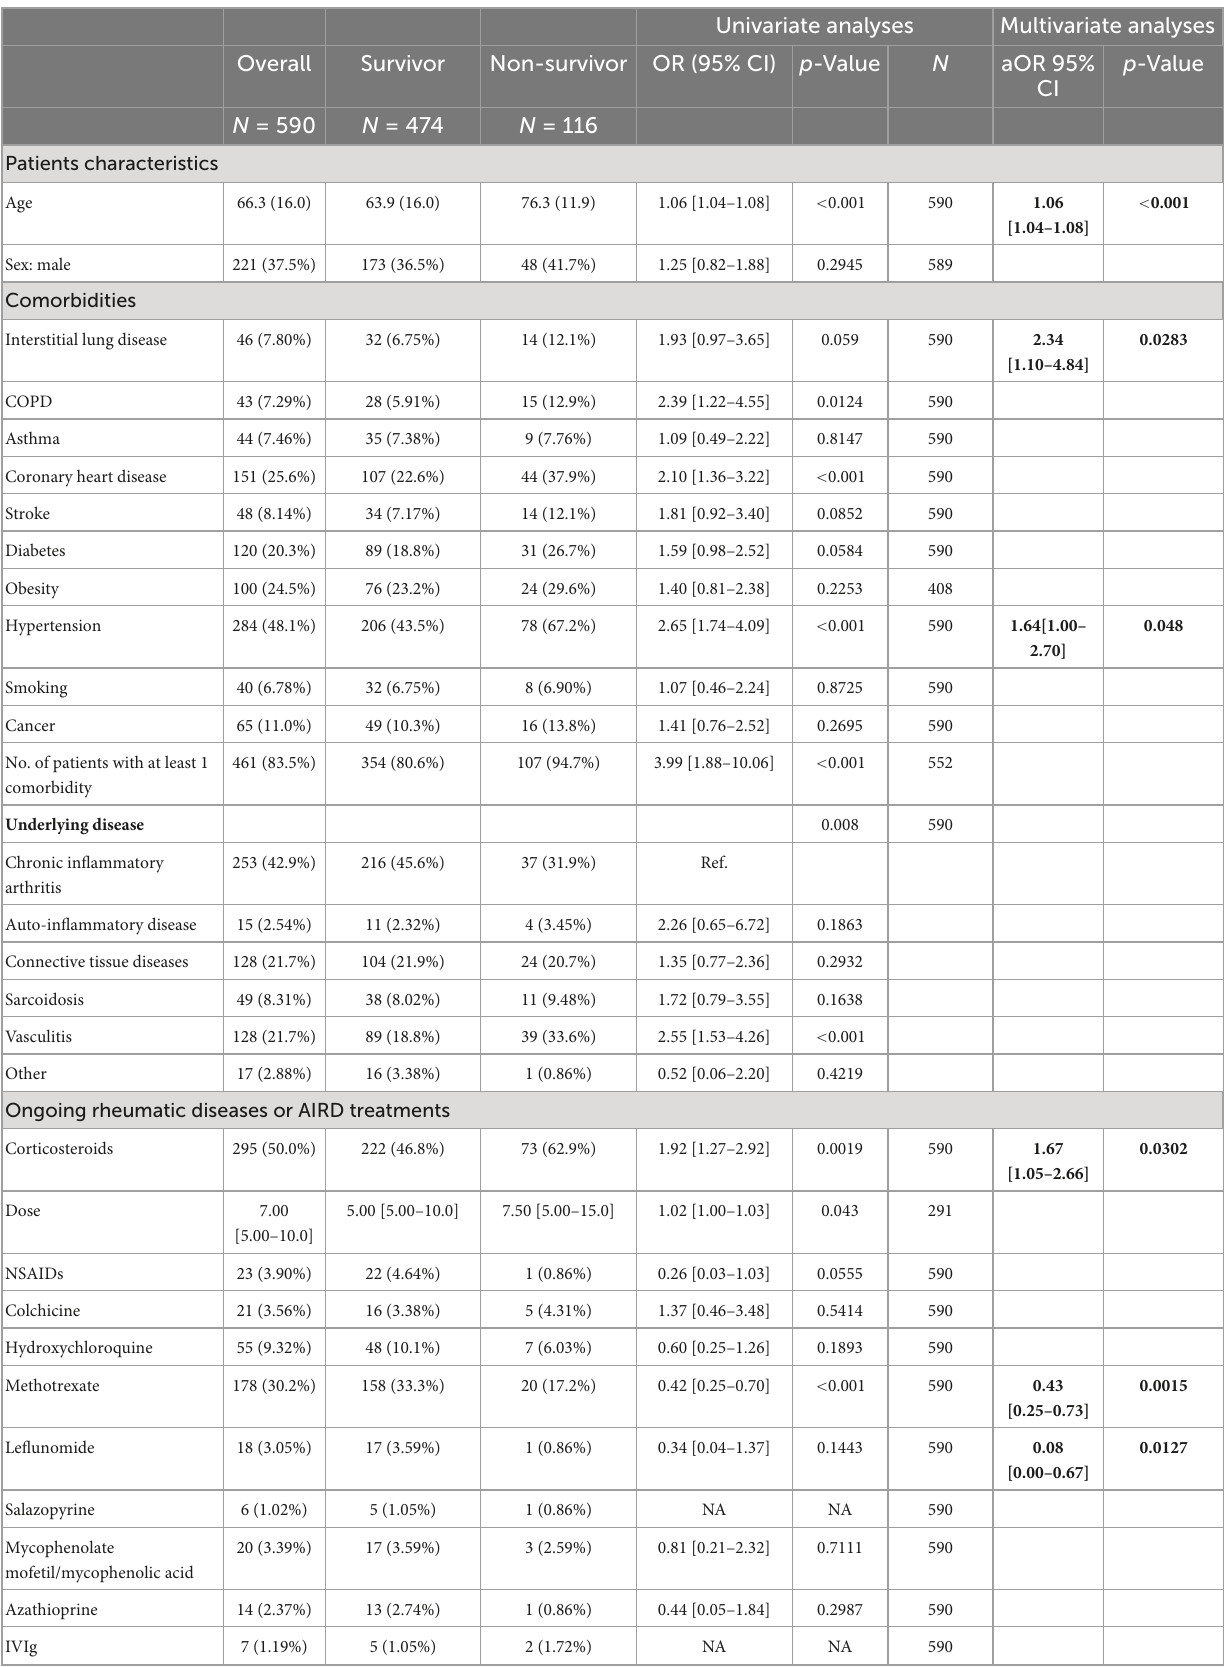
TABLE 3 Factors associated with odds of death from COVID-19 in AIRD patients: Pooled analysis of EDS-COVID and French RMD cohorts. Univariate analyses Multivariate